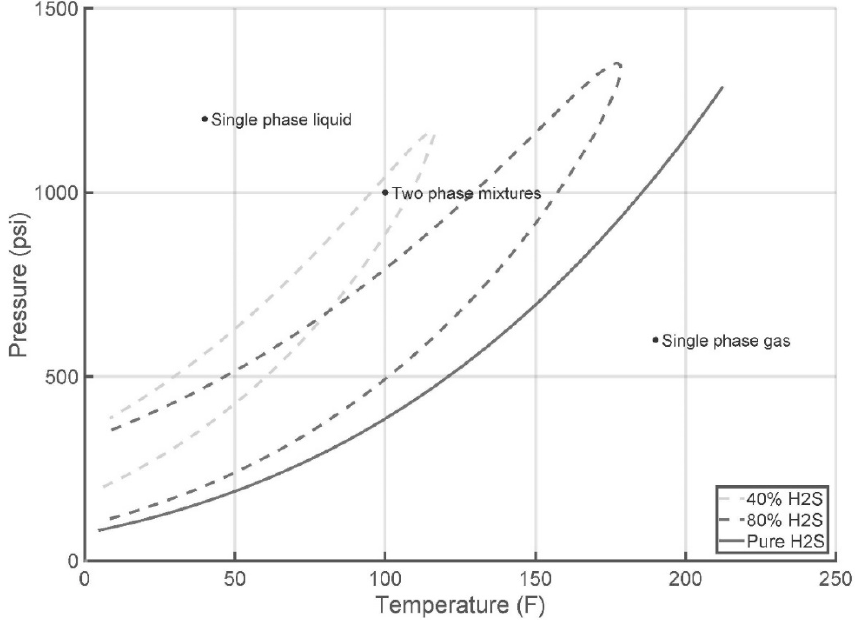
Figure 2. Phase envelopes for acid gas mixtures.